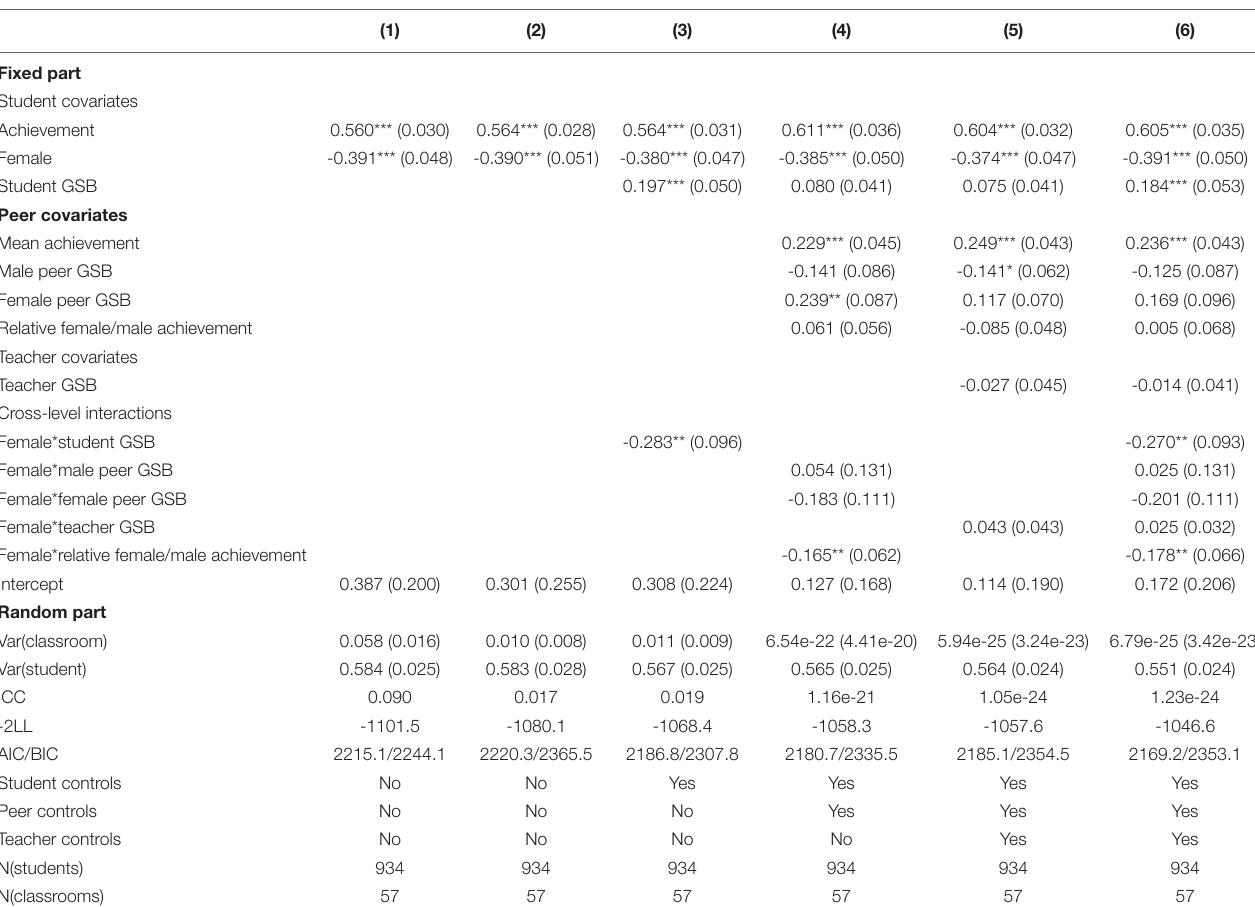
TABLE 3 | Results from a multilevel model of self-concept in mathematics.